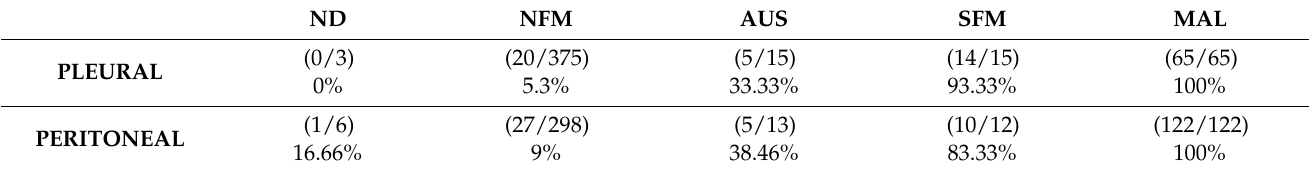
Table 5. Risk of malignancy (ROM) for the TIS categories in pleural and peritoneal